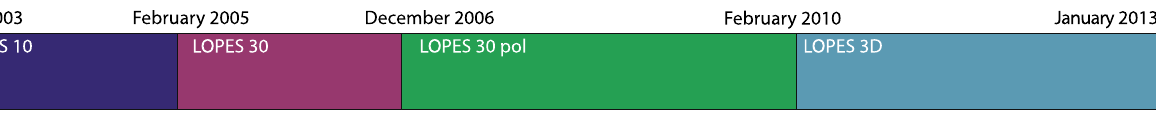
Fig. 2 Timeline of the LOPES experiment: Starting with 10 east-west aligned antennas of the inverted v-shape dipole type (LOPES 10), LOPES was soon extended to 30 such antennas (LOPES 30). End of 2006, half of these antennas were rotated by 90 ◦ to north-south align-